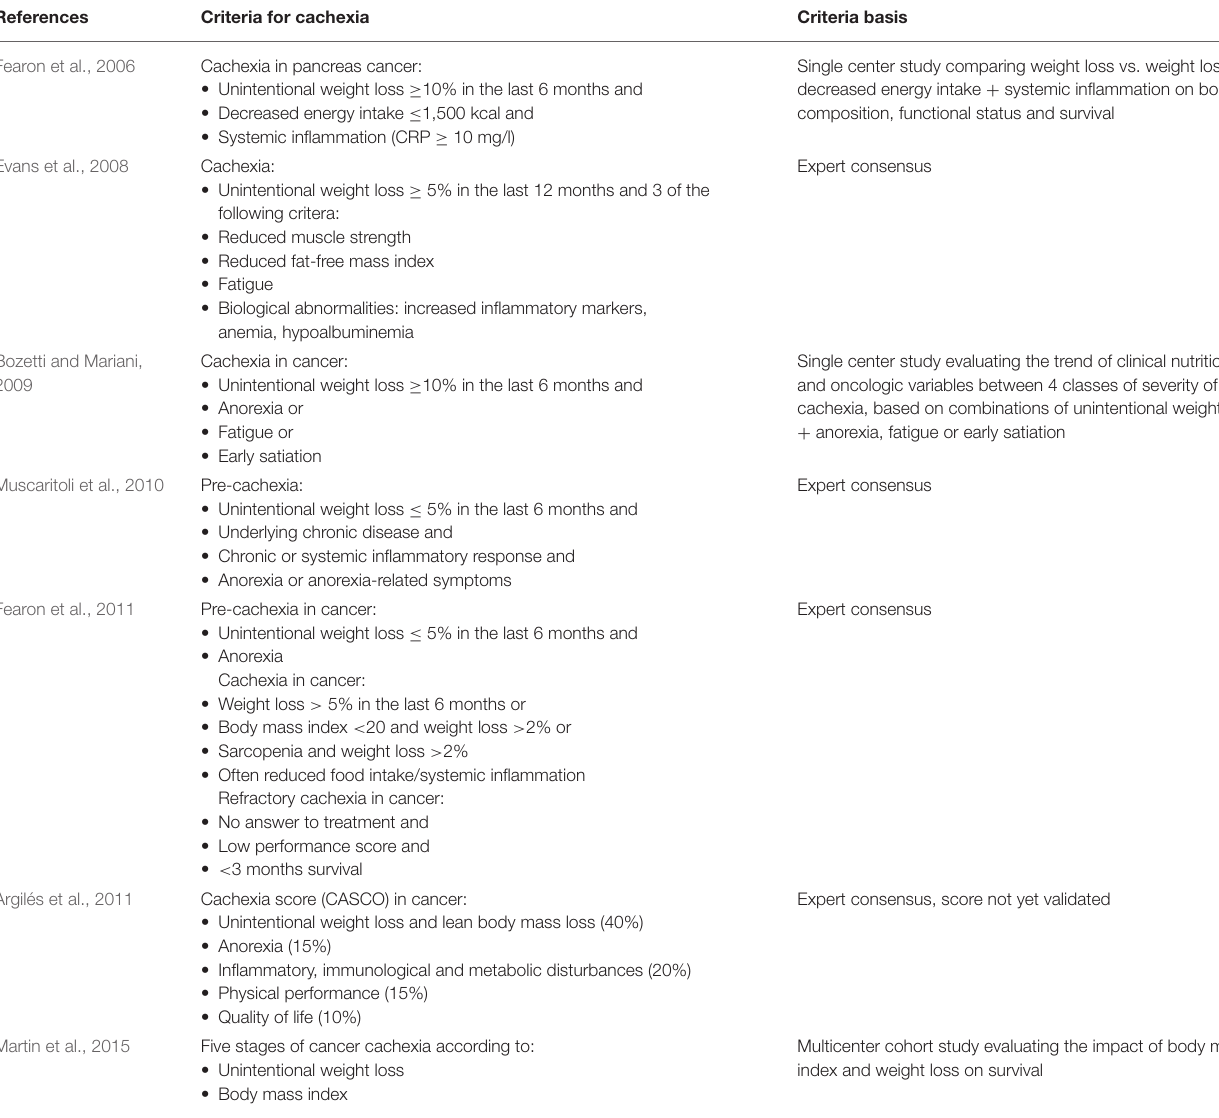
TABLE 1 | Definitions of